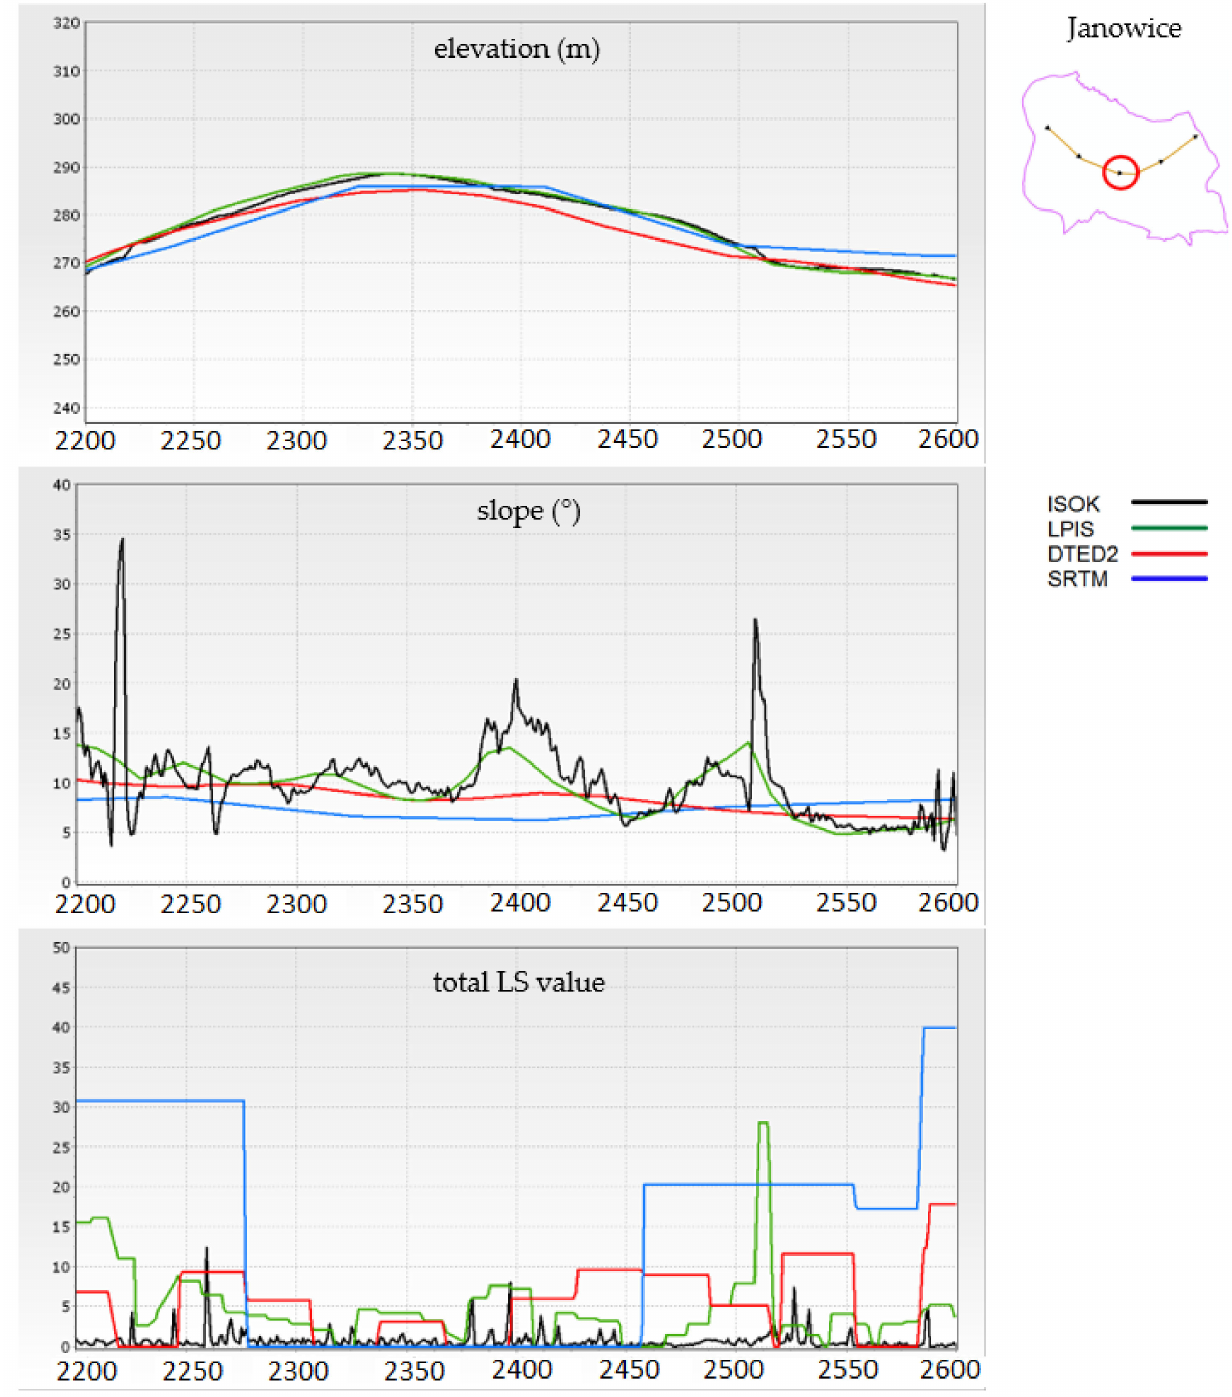
Figure A3. Visualisation of the elevation (m), slopes ( ◦ ) and the total LS factor values (Y-axis) calculated from all the DTM sources for a selected section of the profile (over a 400-m section) for the Janowice research